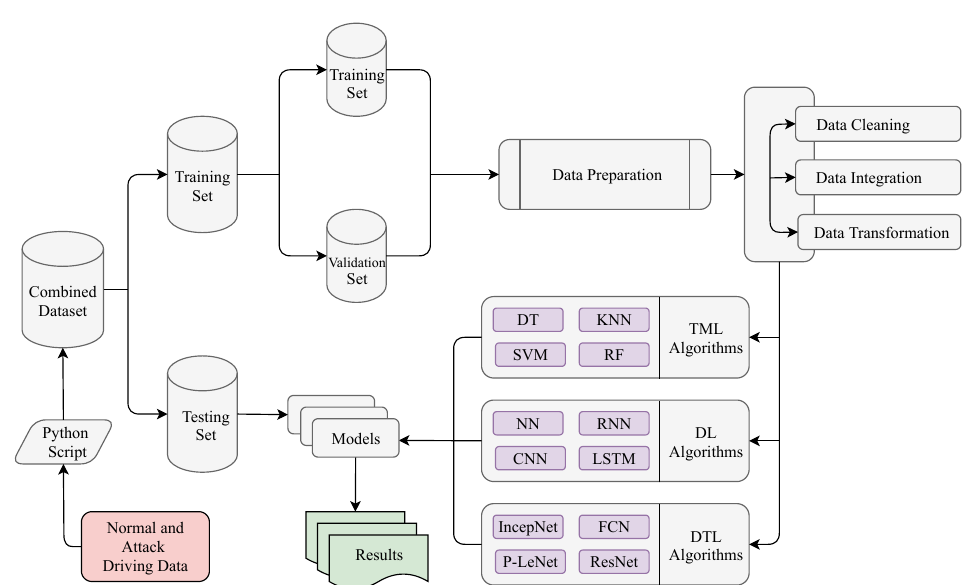
Figure 8. Evaluation process on the datasets with the selected